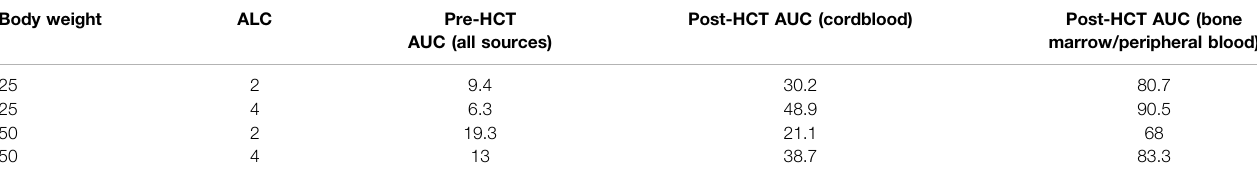
TABLE 1 | Attainment of desired pre- and post-HCT Area Under the Curve. Body weight ALC Pre-HCT AUC (all sources)